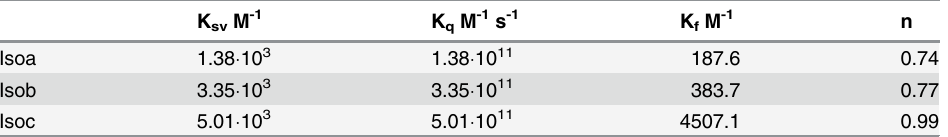
Table 2. Stern-Volmer (K sv ), quenching rate consant (K q ), association constants (K f ) and number of binding sites (n) of the interaction between Isoa-c and DNA.